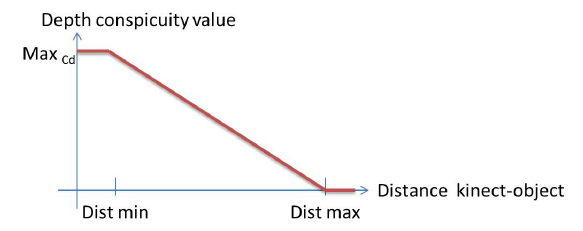
Figure 3. Transformation used to compute depth conspicuity pixel value from original depth